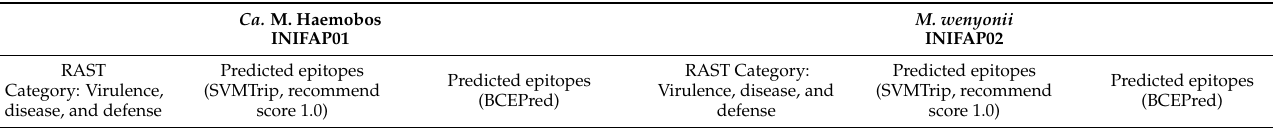
Table 3. B-cell epitopes of Ca . M. haemobos and M. wenyonii predicted by